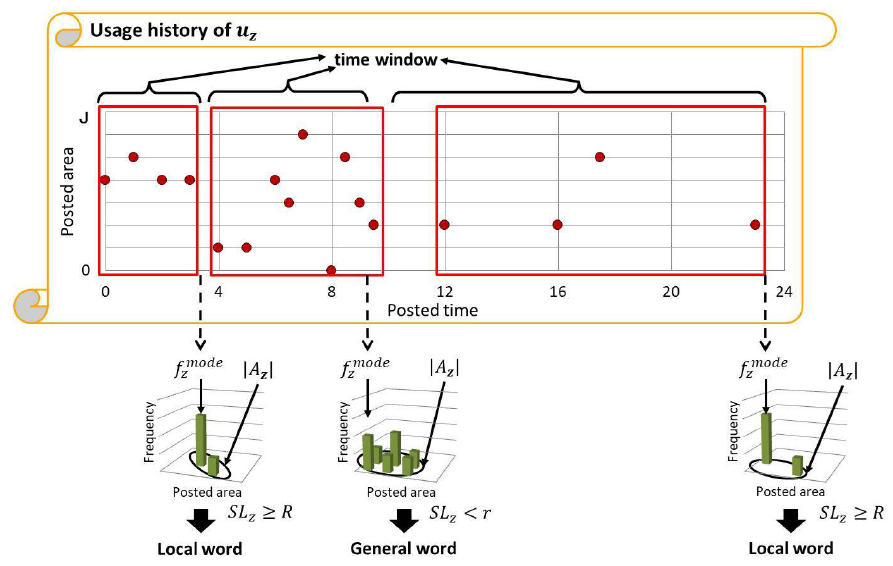
Figure 2. Usage history of u z is accumulated for time windows of different duration so that its spatial locality is properly